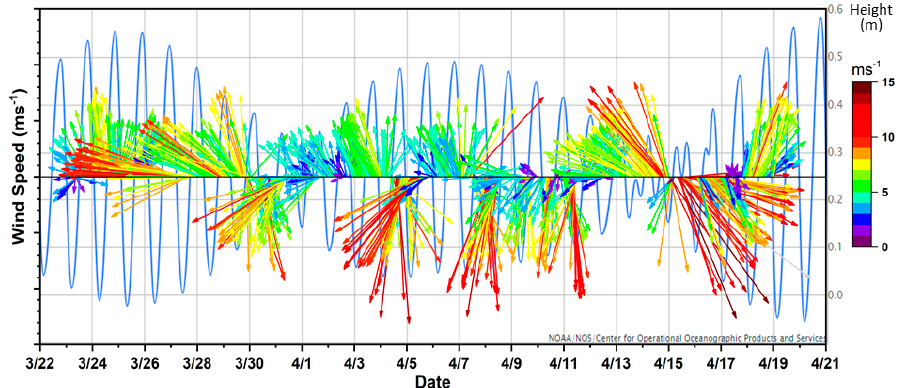
Figure 2. Environmental conditions during the Integrated Coastal Bio-Optical Dynamics ICoBOD field work in 2018. Tidal stage shown in blue (height in m, right axis) with wind vectors overlaid (length and color indicate wind speed, ms -1 ).